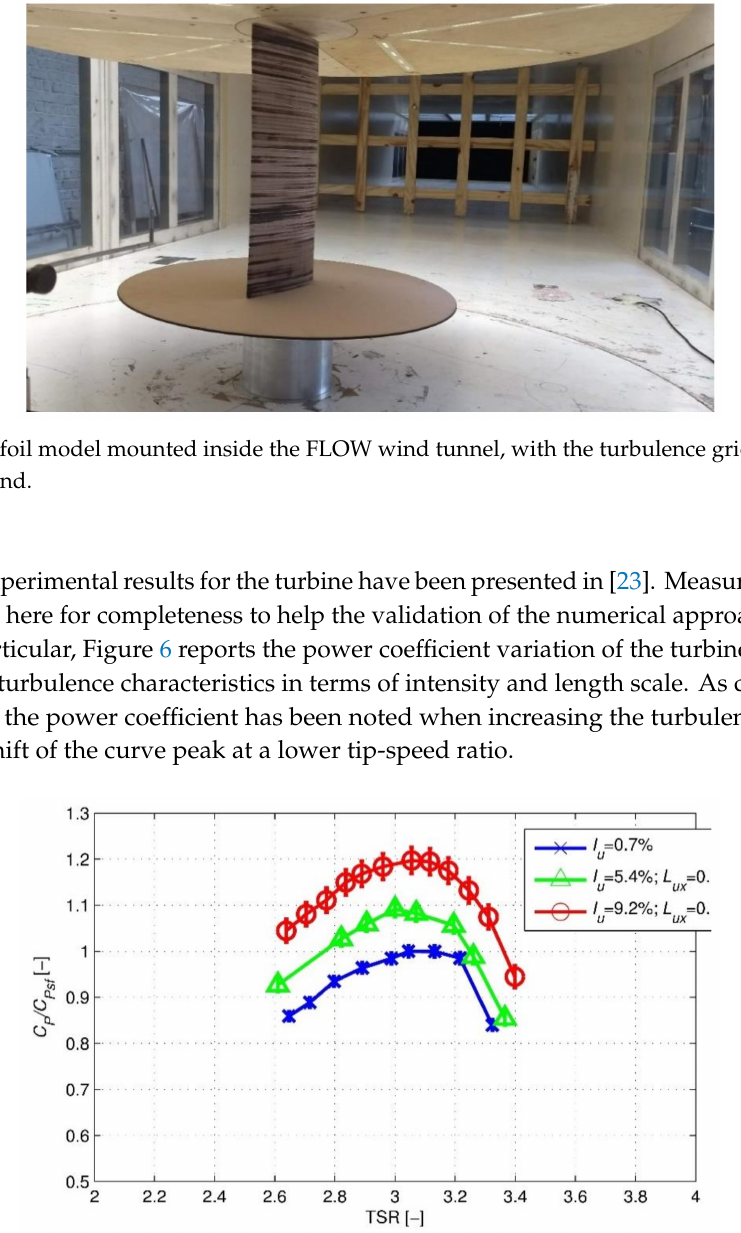
Figure 6. Power curves obtained with the VAWT under di ff erent turbulence conditions, normalized with the optimum C P in smooth